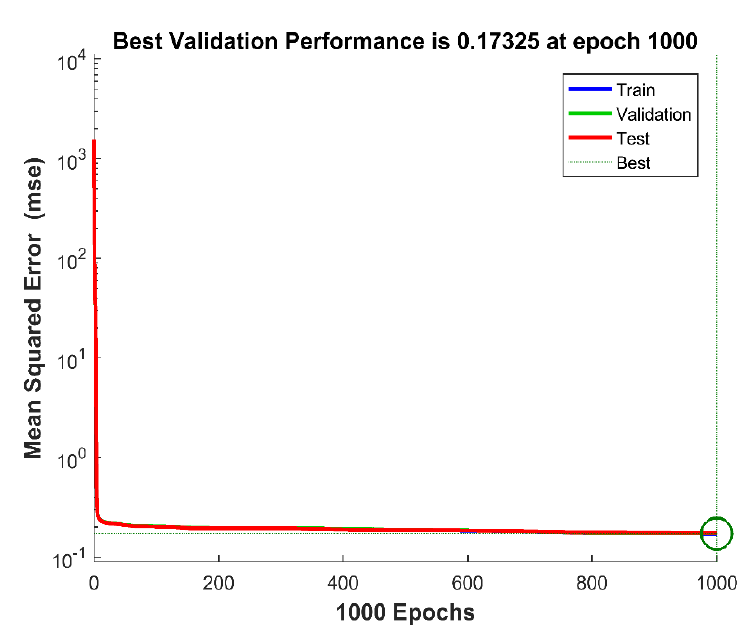
Figure 6. The performance of training, validation and test errors with training epochs.